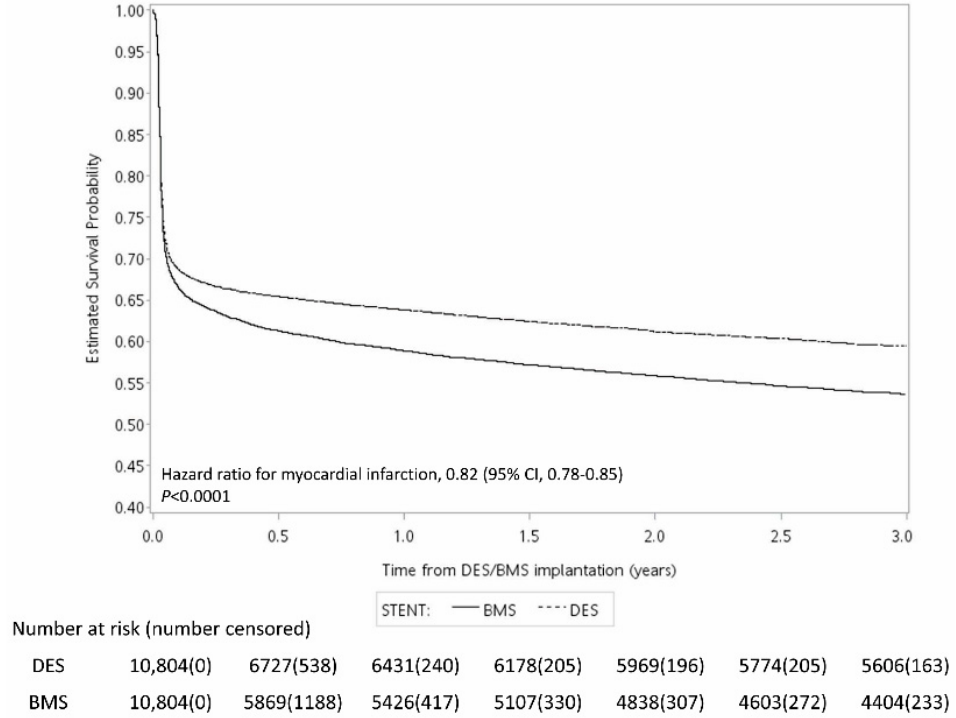
Figure 2. Kaplan–Meier curve for the risk of myocardial infarction within three years after surgery.